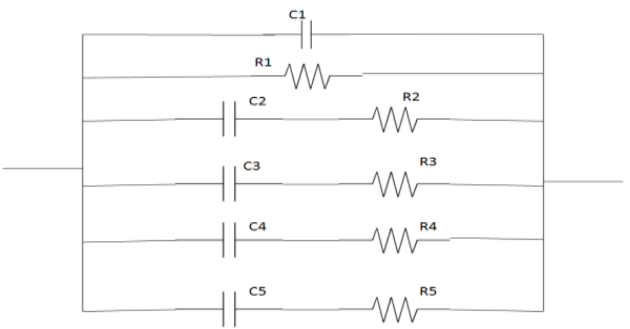
Figure 10. Electrically equivalent circuit to fit EIS data, where R1, R2, R3, R4, and R5 are the resistances; C1, C2, C3, C4, and C5 are the capacitances.